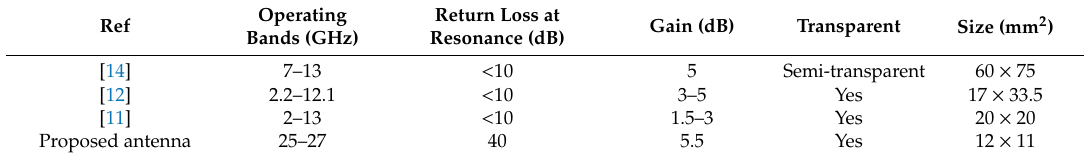
Table 1. Comparison of the proposed transparent antenna with other existing